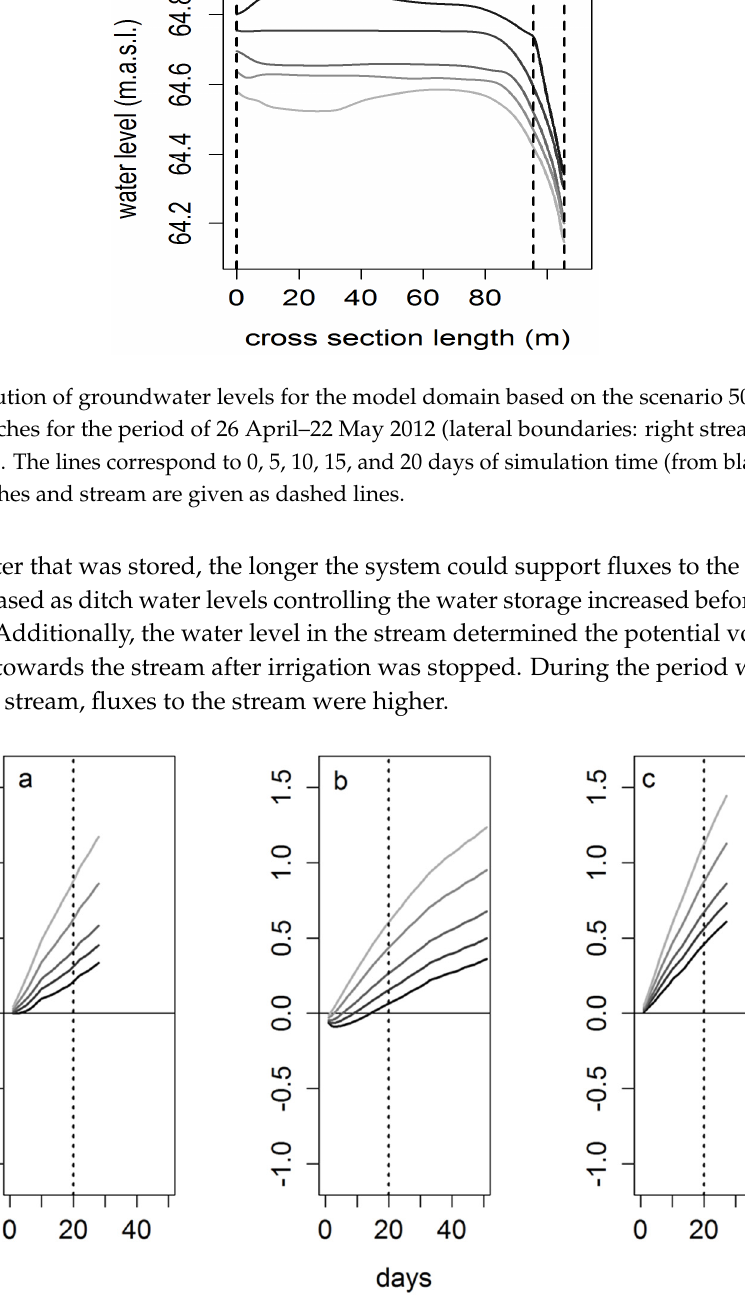
Figure 7. Calculated cumulative fluxes into the stream for the five different scenarios (10 to 50 cm ditch water level, from black to light gray, respectively). Time periods: ( a ) 16 May–12 June 2011; ( b ) 12 October–1 December 2011; and ( c ) 26 April–22 May 2012. Cumulative fluxes are normalized to a width of the 2D-transect of 1 m.